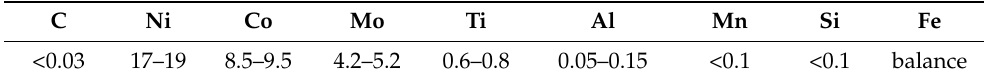
Table 1. Composition percentages of maraging steel powder for SLM